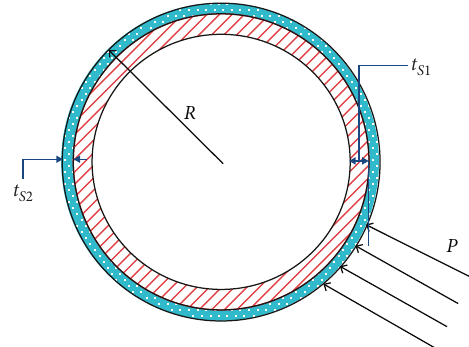
Figure 24: Calculation diagram of supporting structure of sup- porting force (unbiased